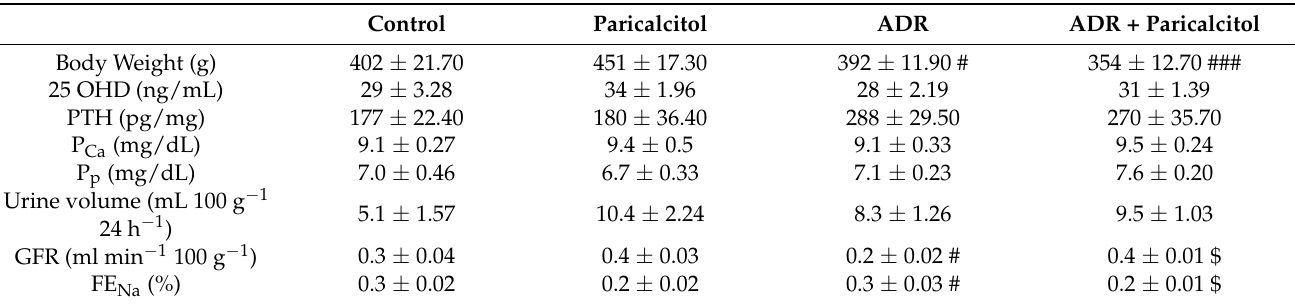
Table 1. Body weight, 25-hydroxyvitamin D, parathyroid hormone, plasma calcium concentration, plasma phosphorus concentration, 24-h urine volume, glomerular filtration rate, and fractional excretion of sodium at the end of the experiment in the control, paricalcitol, ADR, and ADR + paricalcitol groups. Control Paricalcitol ADR ADR + Paricalcitol Body Weight (g) 402 ± 21.70 451 ± 17.30 392 ± 11.90 # 354 ± 12.70